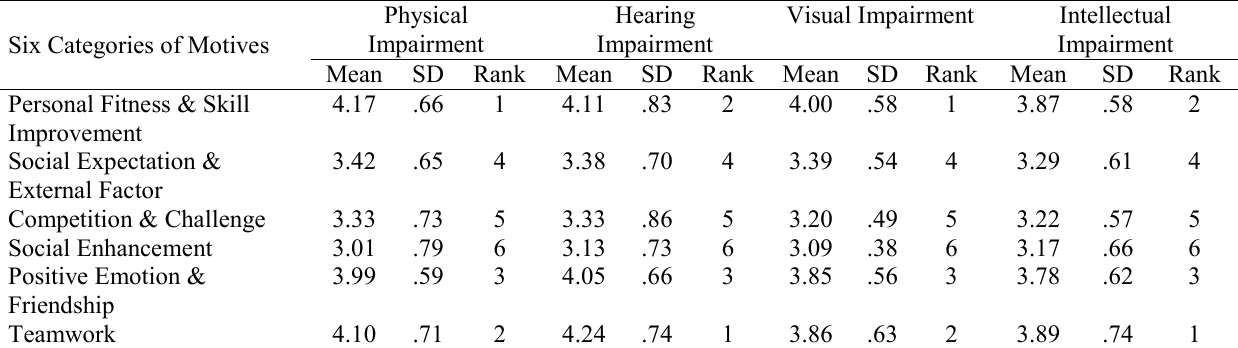
Table 1 Descriptive Data for Impairment Types on the Revised Exercise Participation Motives Questionnaire Six Categories of